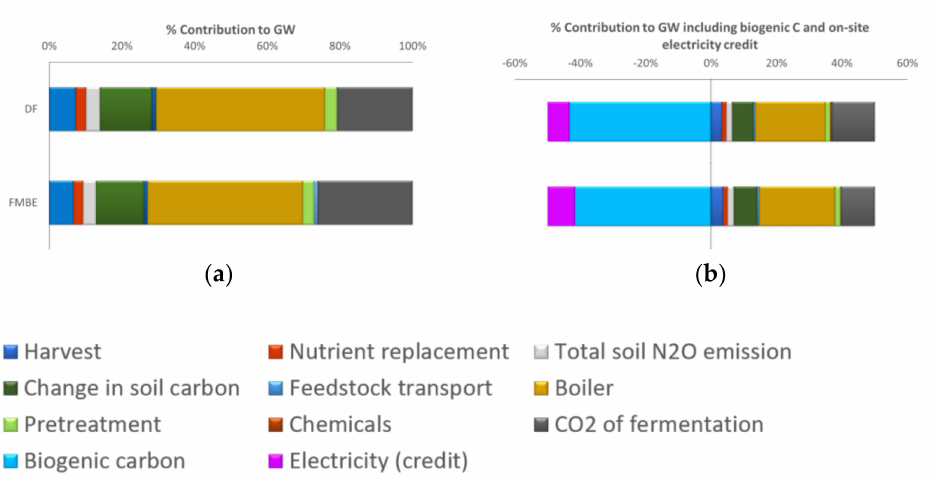
Figure 4. Life cycle percentage component contribution ( a ) positive GW contributions to DF and FMBE process; ( b ) positive and negative GW contributions to DF and FMBE process including negative GWs of biogenic carbon and on-site electricity